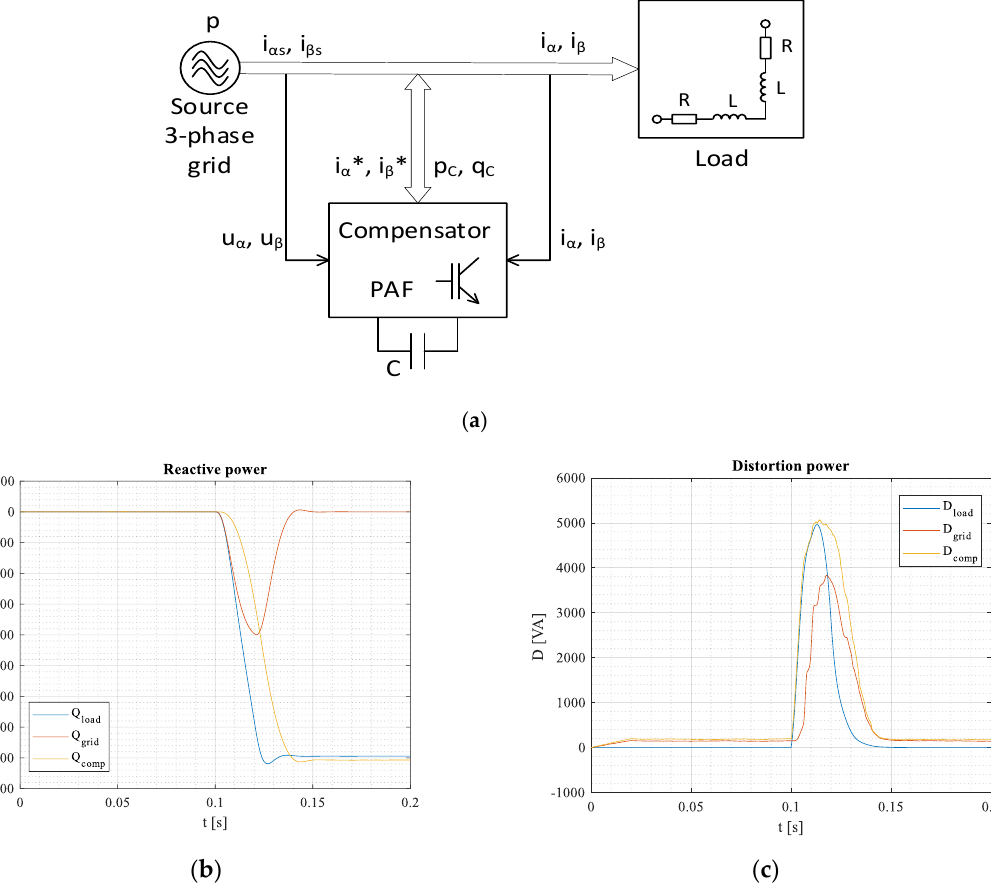
Figure 32. Using PAF active filter ( a ) for compensating reactive blind power ( b ) under linear RL load and distortion power ( c ).